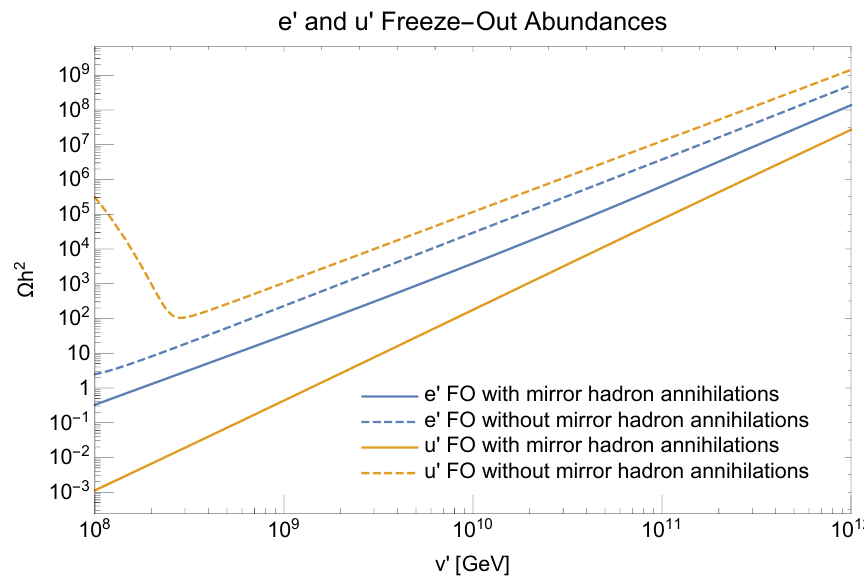
Figure 9 . The cosmological abundance of mirror electrons and up quarks from freeze-out and from decays of heavier charged mirror fermions. Dilution from mirror neutrino decays is not